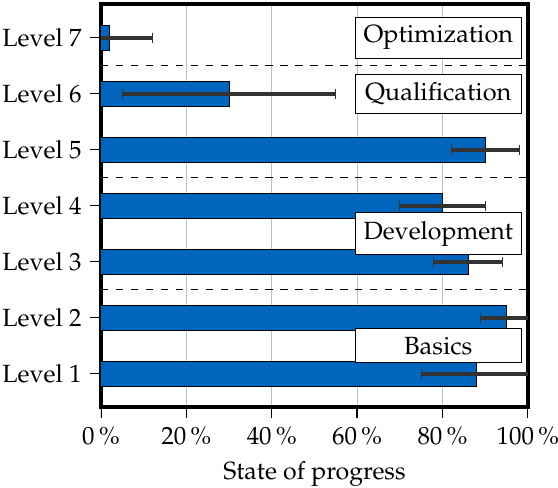
Figure 10. Level of maturity according to the individual development stages, based on the method of Reinhart and Schindler